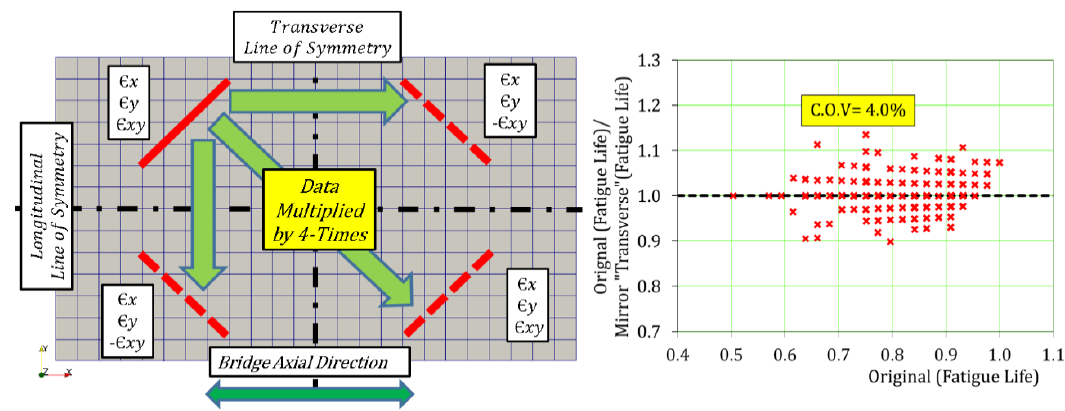
Figure 13. Effect of traffic direction on remaining fatigue lives corresponding to crack patterns.